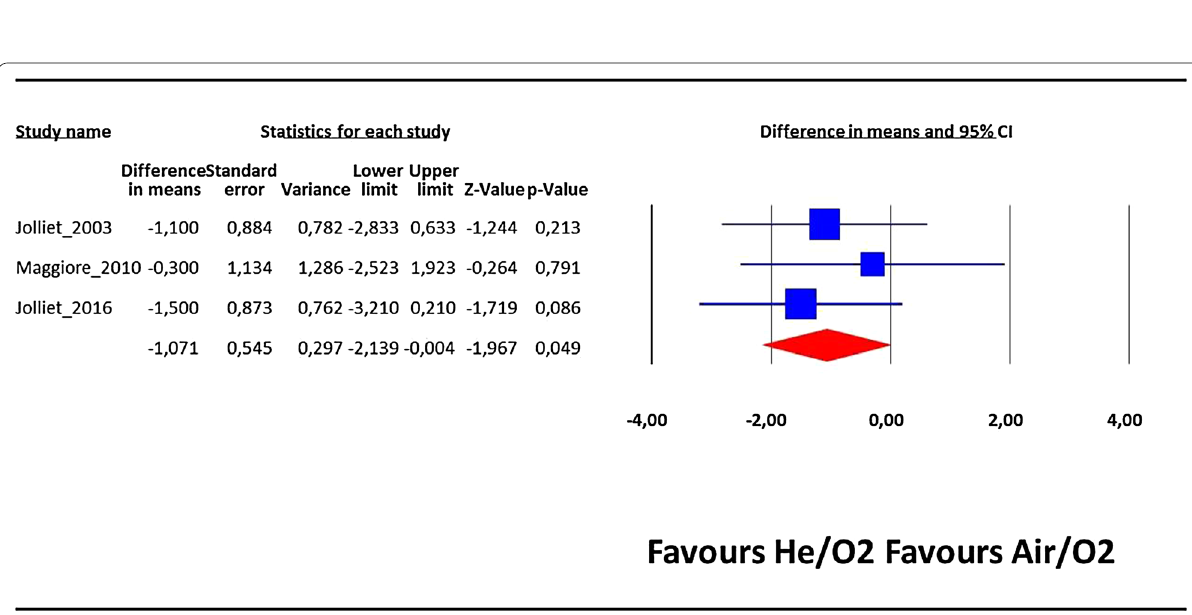
Fig. 5 Length of ICU stay. Estimates are expressed as difference in means and 95% confidence. The length of stay was significantly lower in the He/ O 2 with no heterogeneity between included studies (I 2 :